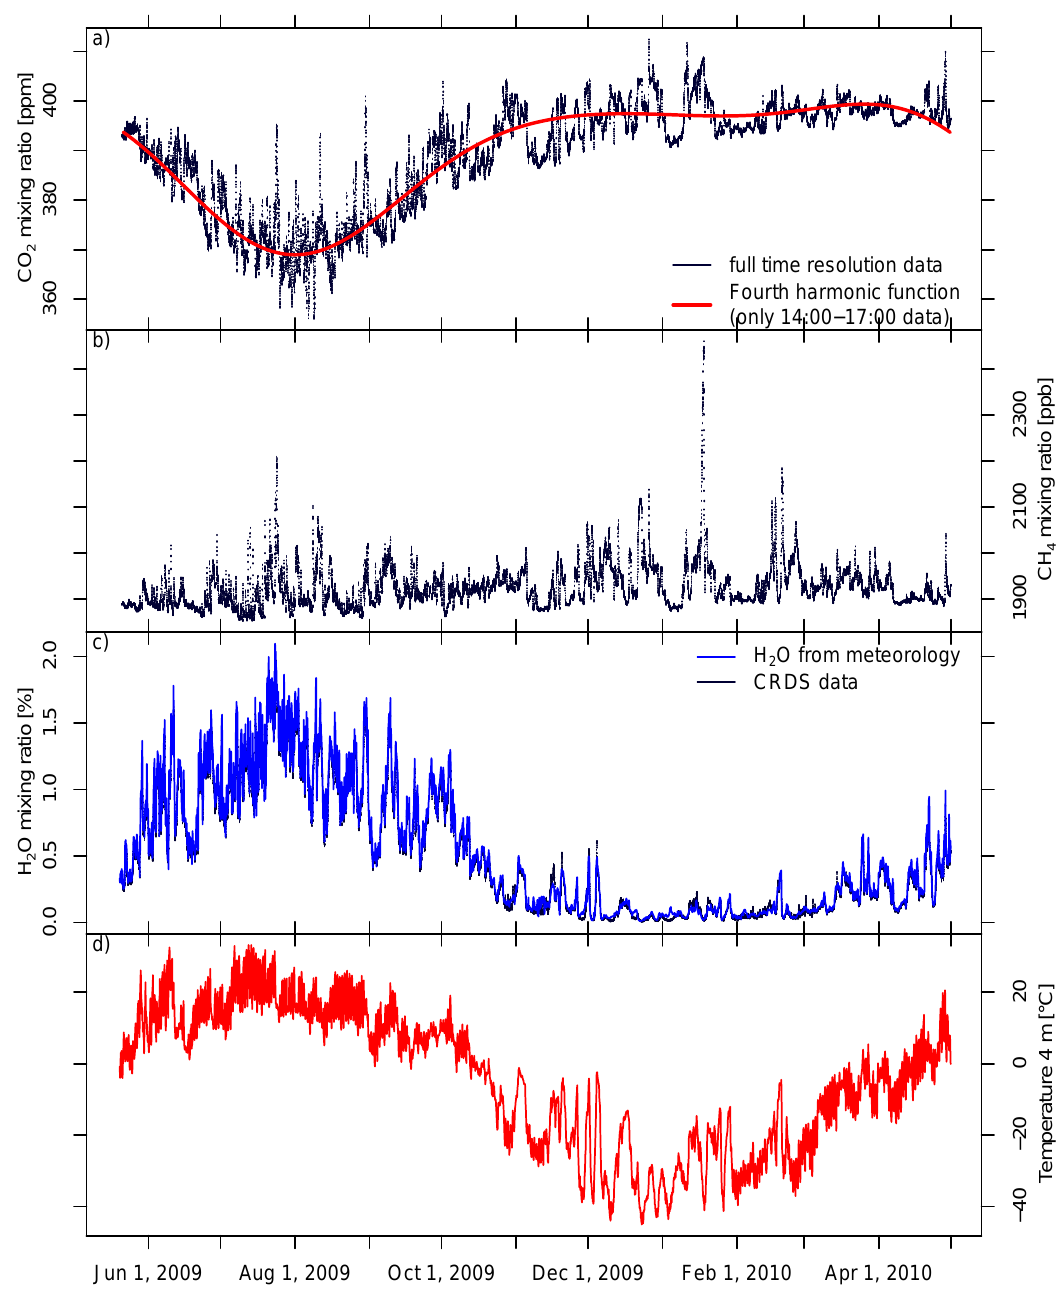
Fig. 8. ZOTTO time series from 20 May 2009 to 30 April 2010 for (a) CO 2 , (b) CH 4 , and (c) H 2 O for 301m height; (d) temperature at 4m